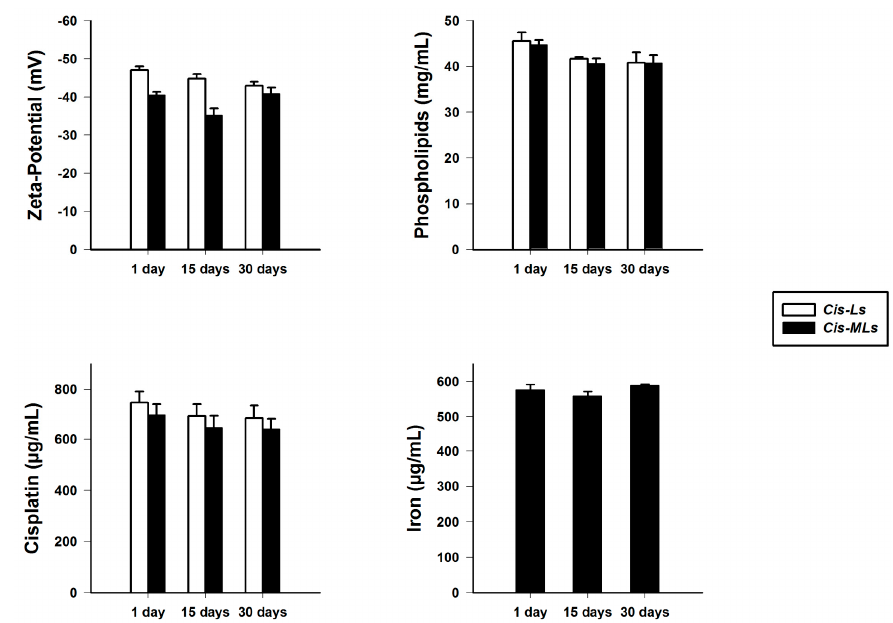
Figure 4. Stability of liposome suspensions in saline solution stored at 4 ◦ C for 15 and 30 days.